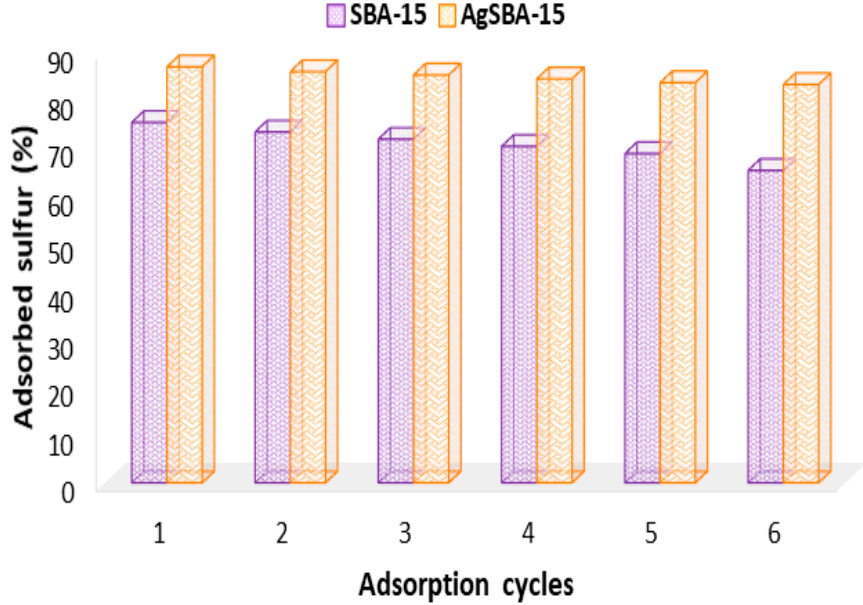
Figure 10. S-adsorption results for six recycles with the regenerated SBA-15 and 2AgSBA-15 materials.